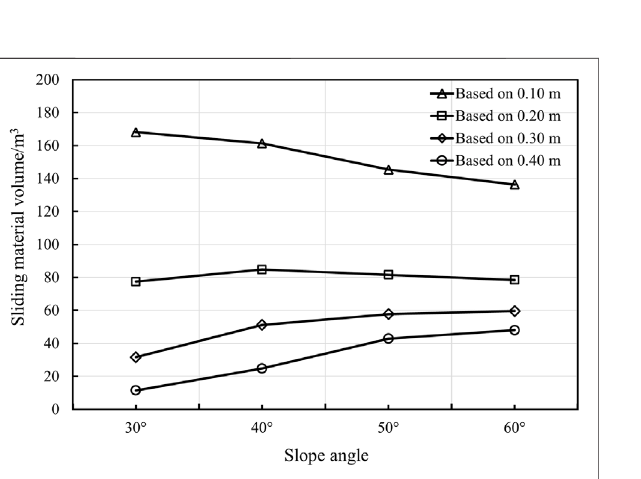
FIGURE 8 | Sliding material volume comparison when the threshold is 0.20 m.